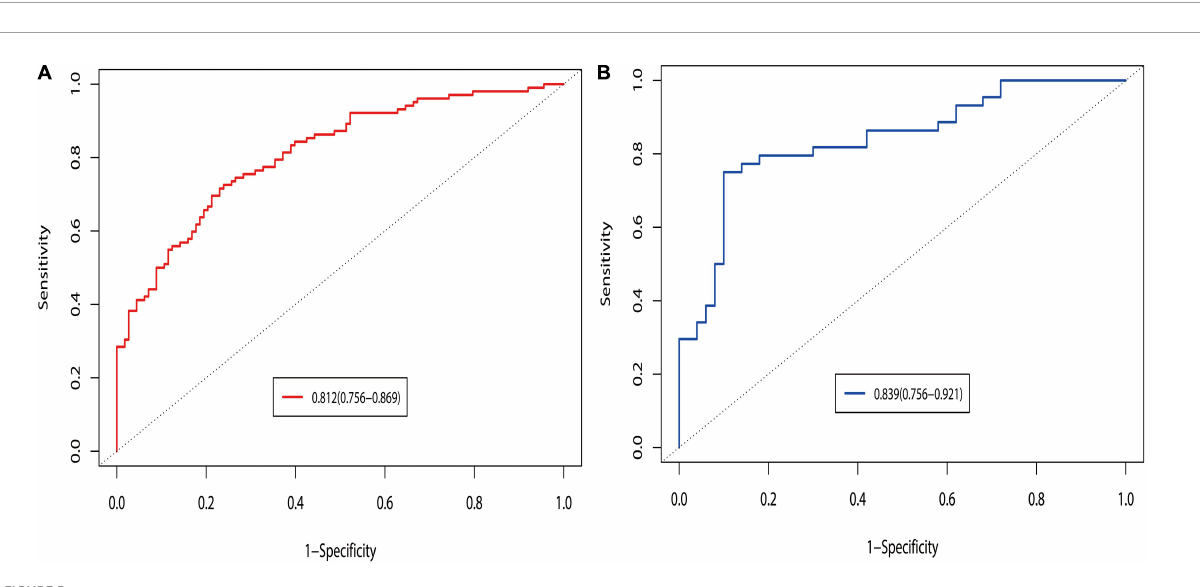
FIGURE5 Discrimination of ROC curves in the development (A) and validation (B) sets. The prediction probability was calculated based on the development set model, and the discrimination of the model was evaluated by ROC curves under development and validation sets. Logit P = 0.862 + 1.263 Splenomegaly grade (Moderate vs. Mild) + 1.704 Splenomegaly grade (Severe vs. Mild) + 0.137 POD14D-dimer (mg/L) + 0.016 POD7PLT ( × 109/L) + 0.159 PVD + 0.188 SVD-0.311 PVV- 0.010 PVF. Probability of prediction = exp (Logit P)/[1 + exp (Logit